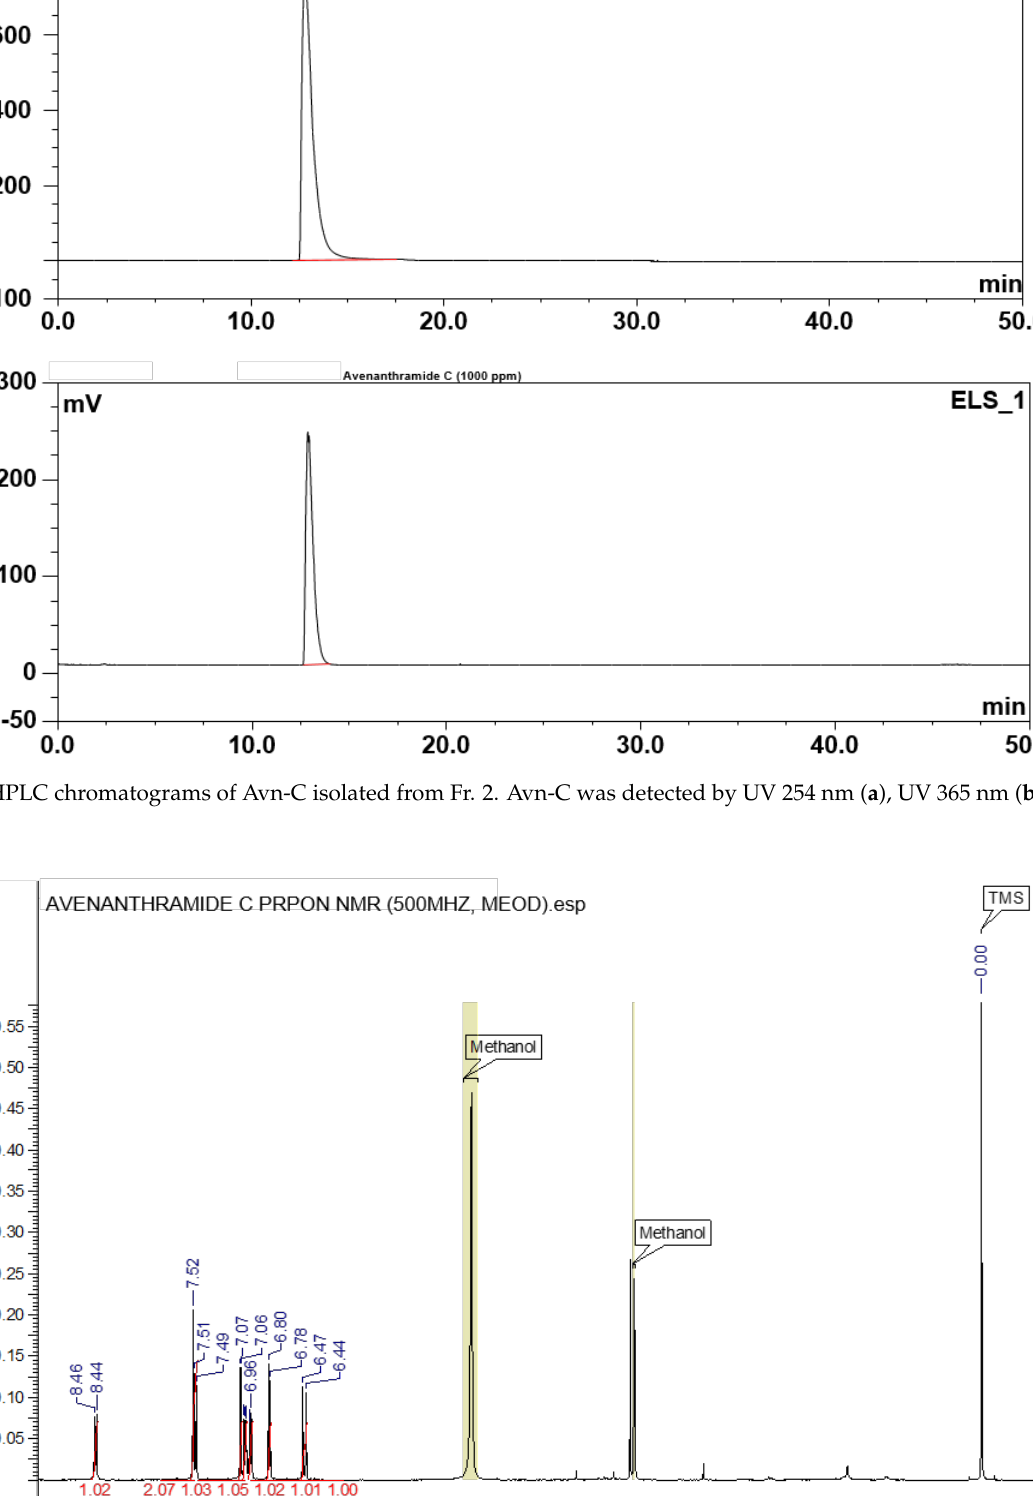
Figure 3. 1 H NMR spectra of Avn-C (MeOH-d4). (a) The whole spectrum. (b) The magnified spectrum from 9.0 to 6.0 ppm. H O